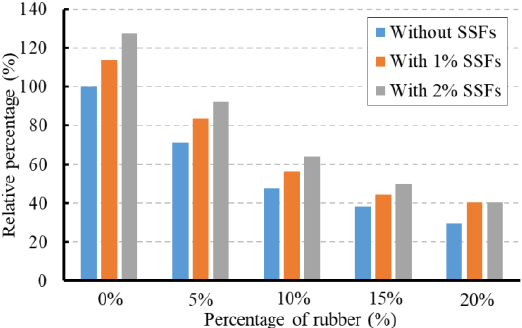
Figure 23. Modulus of elasticity of concrete with CR and SSFs normalized to the reference mix.